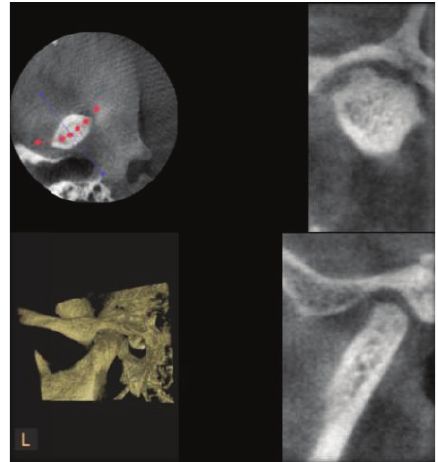
Figure 8: Resorption of condyle as seen in DVT.